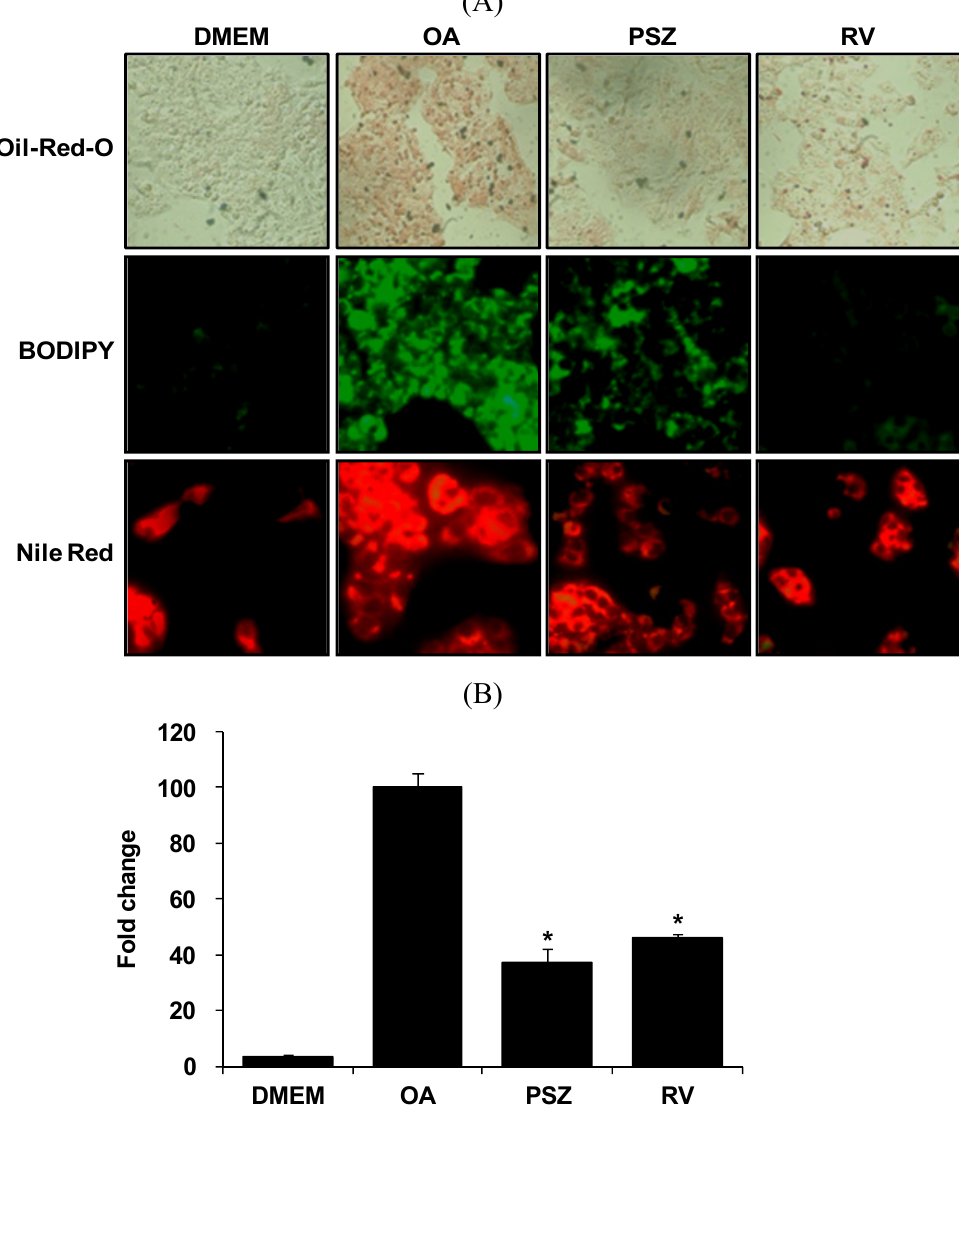
Figure 2. Effects of Pinus densiflora Sieb. et Zucc. (PSZ) on steatosis in HepG2 cells stimulated with oleic acid (OA). ( A ) HepG2 cells were treated with 100 μ g/mL PSZ. After treatment for 24 h, lipid accumulation was measured by staining with Oil-red-O, BODIPY, and Nile Red. ( B ) Lipid accumulation was quantified by measuring the extracted dye at 510 nm. Results are the mean ± SEM from three independent experiments. * p < 0.05 compared with the OA group. DMEM, control group; OA, oleic acid-treated group; PSZ, OA + Pinus densiflora Sieb. et Zucc. - treated group; RV, OA + resveratrol-treated